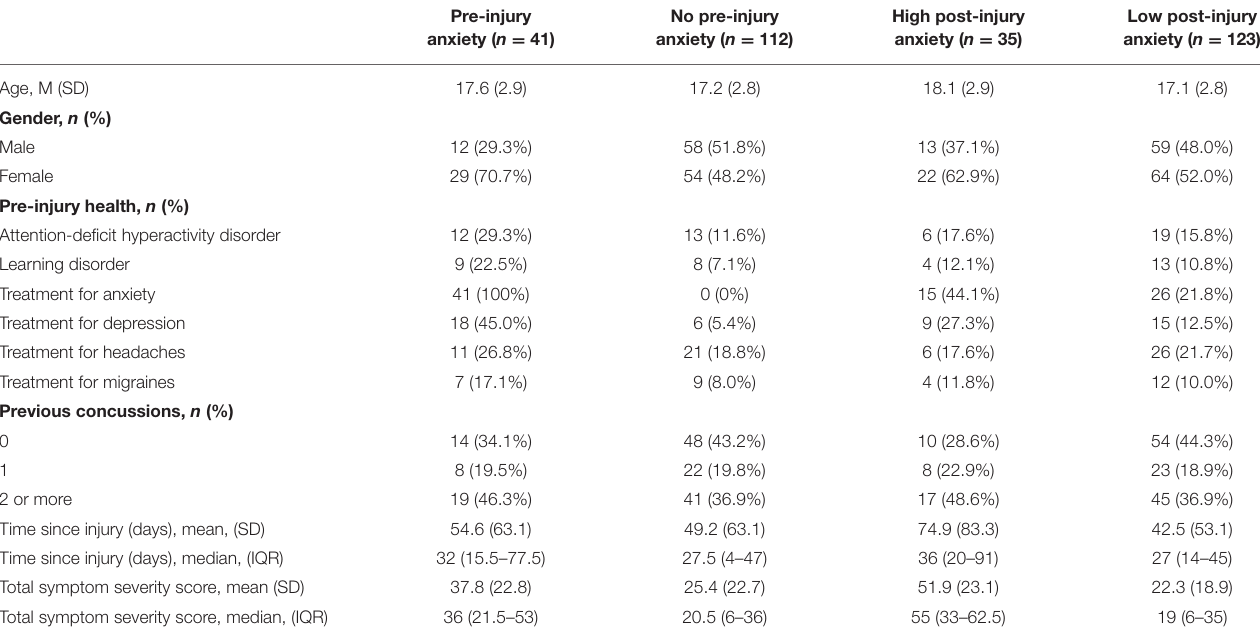
TABLE 1 | Characteristics of the high and the low anxiety